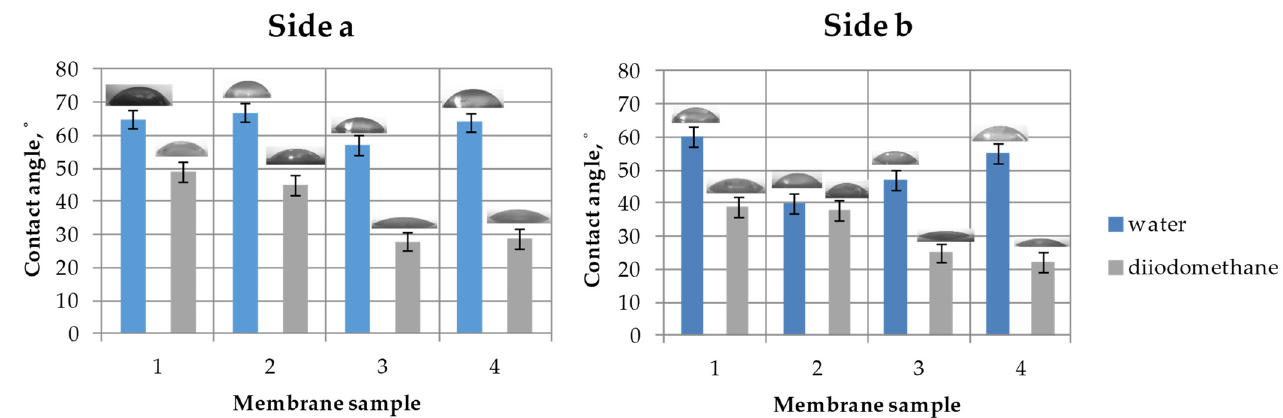
Figure 6. Water and diiodomethane contact angles: left —side a ; right —side b .